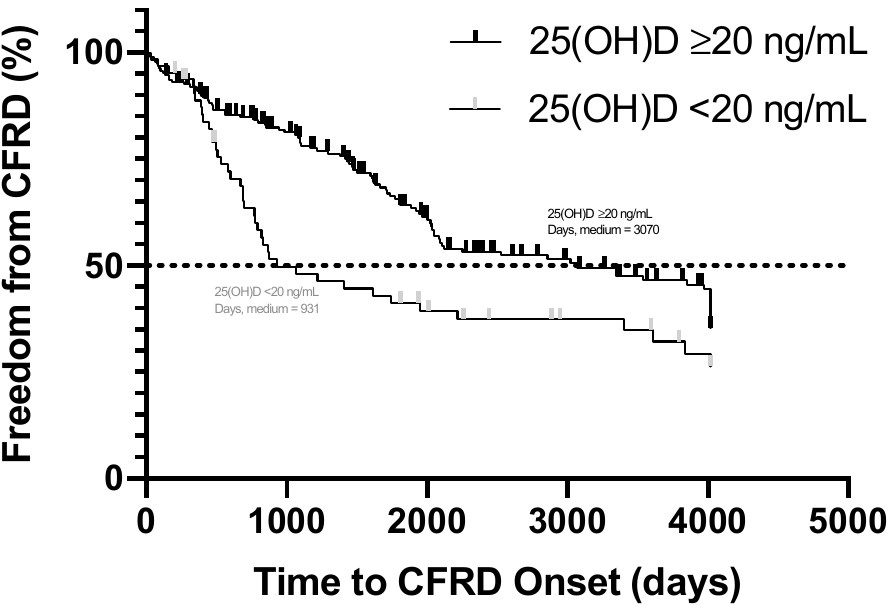
Figure 1. Time in days to cystic fibrosis-related diabetes (CFRD) onset by vitamin D status (25(OH)D < and ≥ 20 ng/mL). Hazard ratio of the vitamin D deficient subjects to not vitamin D deficient subjects is 1.76 (95% CI: 1.2, 2.7, p = 0.0078). The medium for days of CFRD onset was 931 for subjects with vitamin D deficiency and 3070 for those